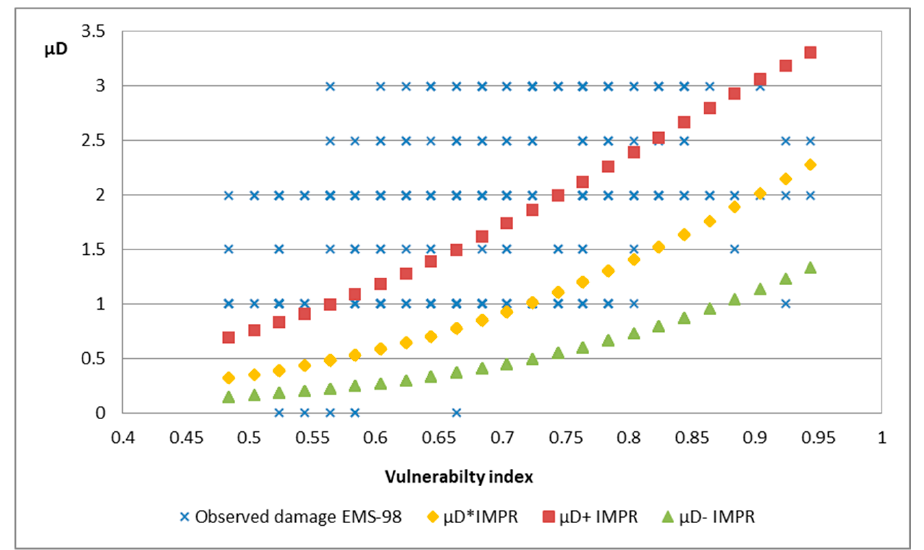
Figure 4. Graphical comparison between EMS-98 observed damage on RC buildings from earthquake of Lorca (blue crosses), and the mean damage degree calculated with the RISK-UE LM1 model for an I EMS -98 = VII earthquake, where µ D * is the representative mean damage value (yellow) and [ µ D − , µ D+ ] the range of the estimated mean damage degree (red and green dots) [33].